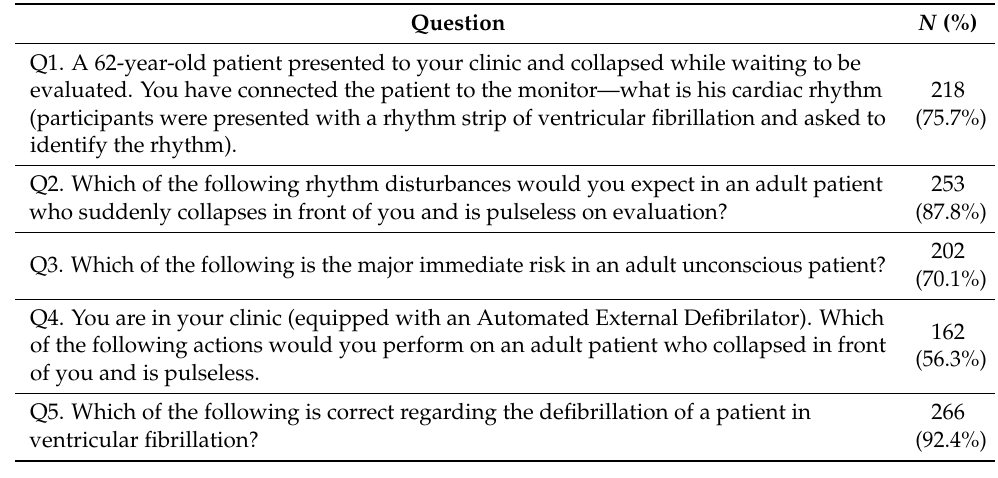
Table 3. Distribution of knowledge question responses in all participants in absolute numbers and percentage